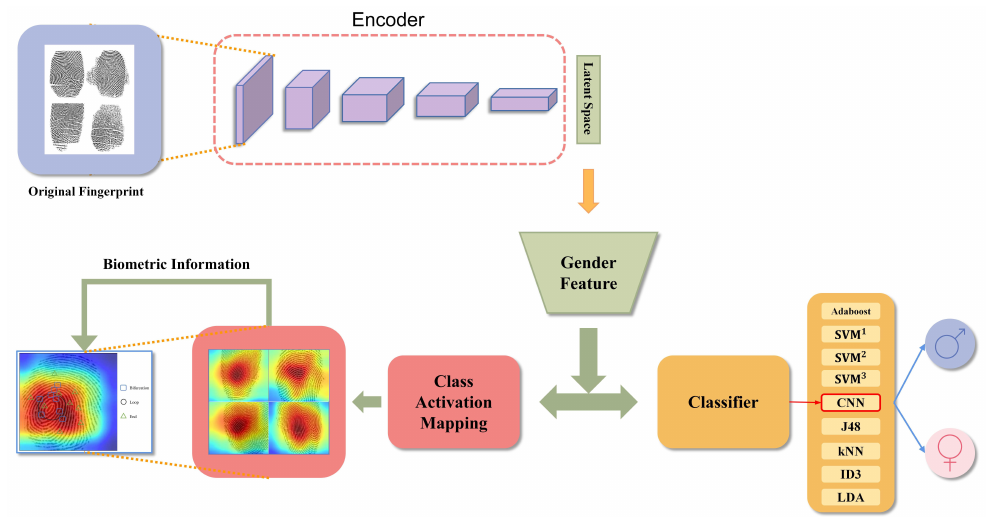
Figure 2. Methodologies Demonstrate: The original fingerprint images will walk through an encoder (DDCResNet) to extract gender features. The gender features could be used in class activation for biometric information or in a classifier (CNN) for gender classification.